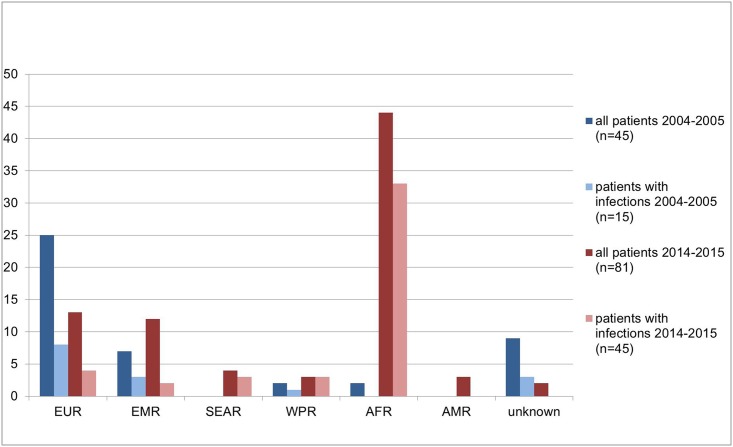
Comparison of all hospitalized patients (n = 126) and hospitalized patients with infections (n = 60) between both study periods stratified by region of origin.AFR: African Region; AMR: Region of the Americas; EMR: Eastern Mediterranean Region; EUR: European Region; SEAR: South-East Asia Region; WPR: Western Pacific Region.